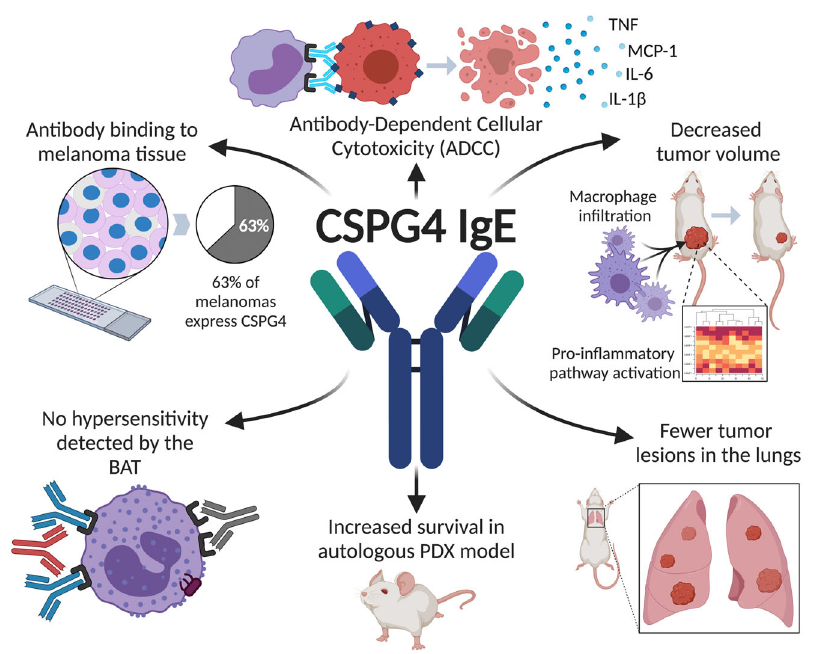
Fig. 9 | Ef fi cacy and mechanism of action of an IgE antibody speci fi c for the tumor-associated antigen CSPG4 to target melanoma support the develop- ment ofIgE therapiesforCSPG4-expressingtumors. CSPG4 IgE bound to a high proportion of melanomas, including metastases. CSPG4 IgE-mediated antibody- dependent cellular cytotoxicity (ADCC) of CSPG4-expressing melanoma cells by immune effector cells from healthy volunteers or patients with melanoma and stimulatedhumanFc ɛ RI-expressingeffectormonocytestowardspro-in fl ammatory